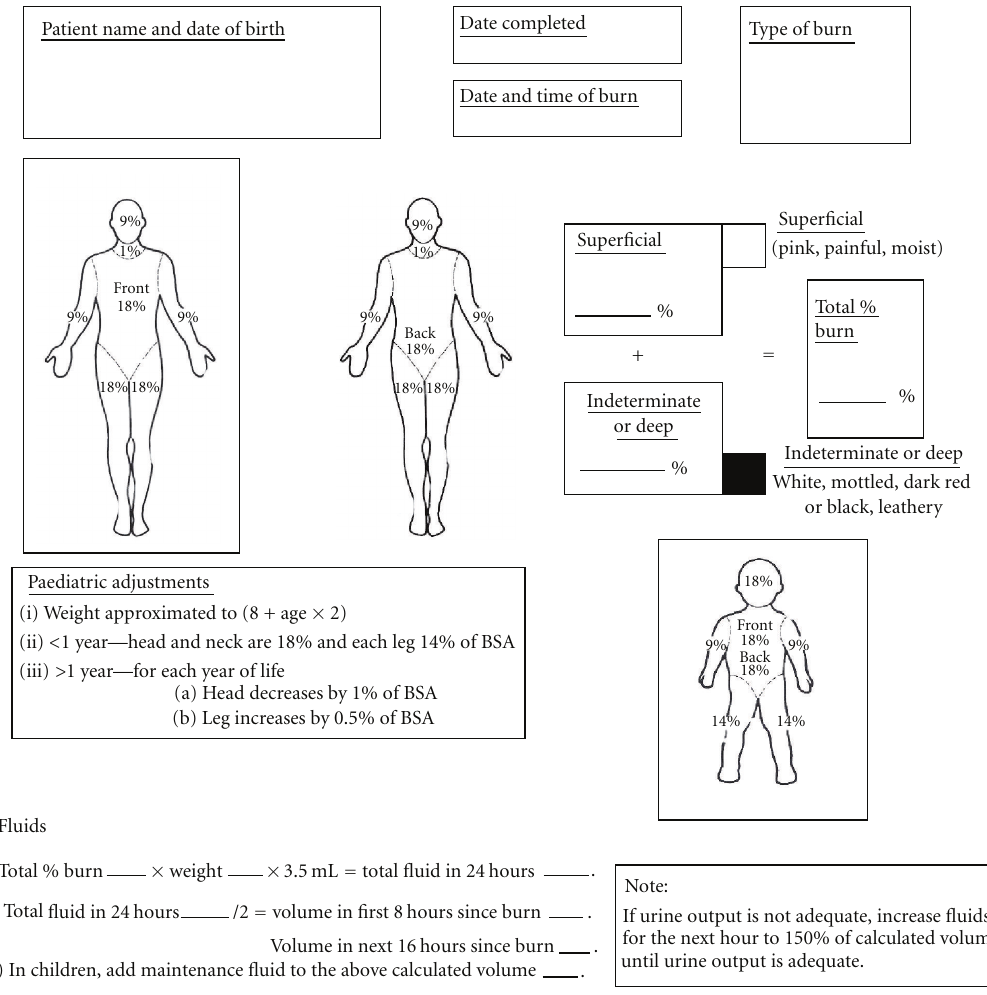
Figure 1: South African Burn Society Burn Assessment